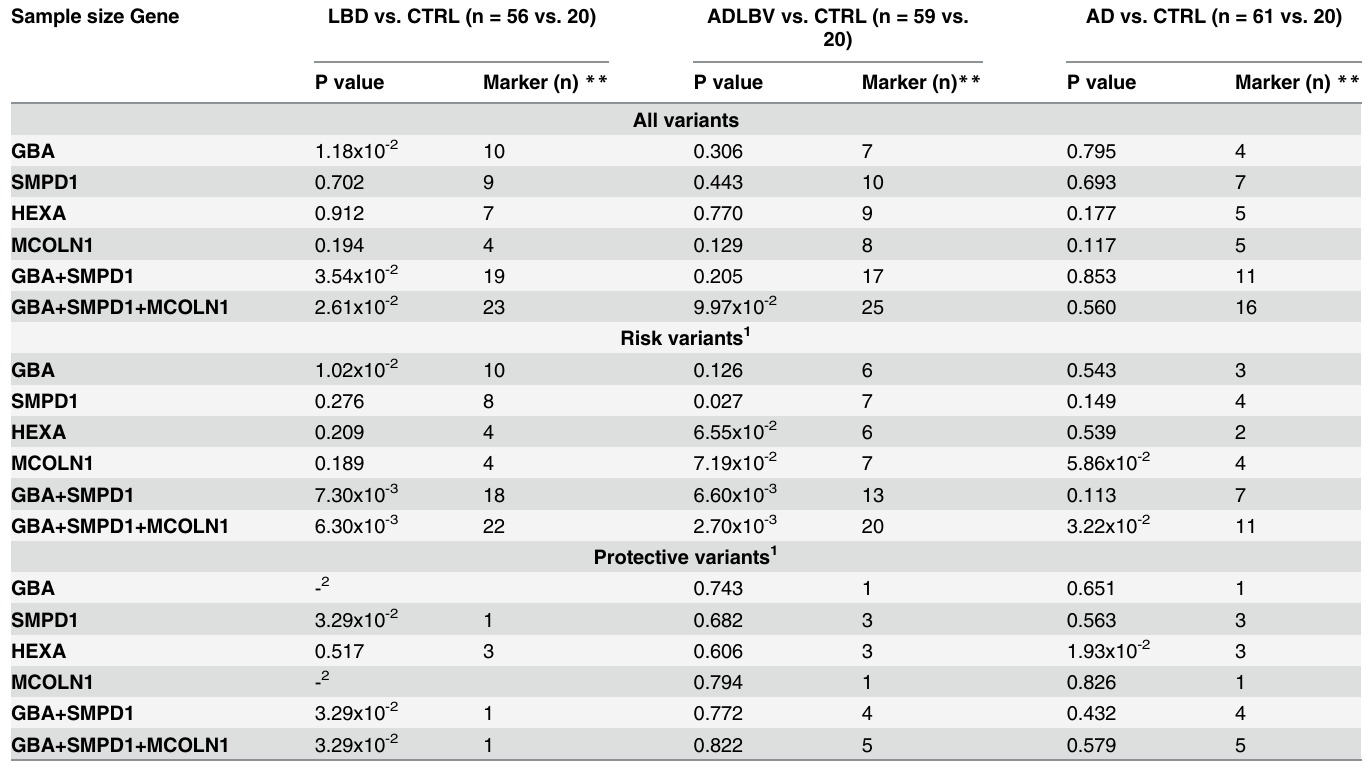
Table 5. Gene wise SKAT analysis of LSD variants with MAF < 0.05 in White subjects only. Sample size Gene